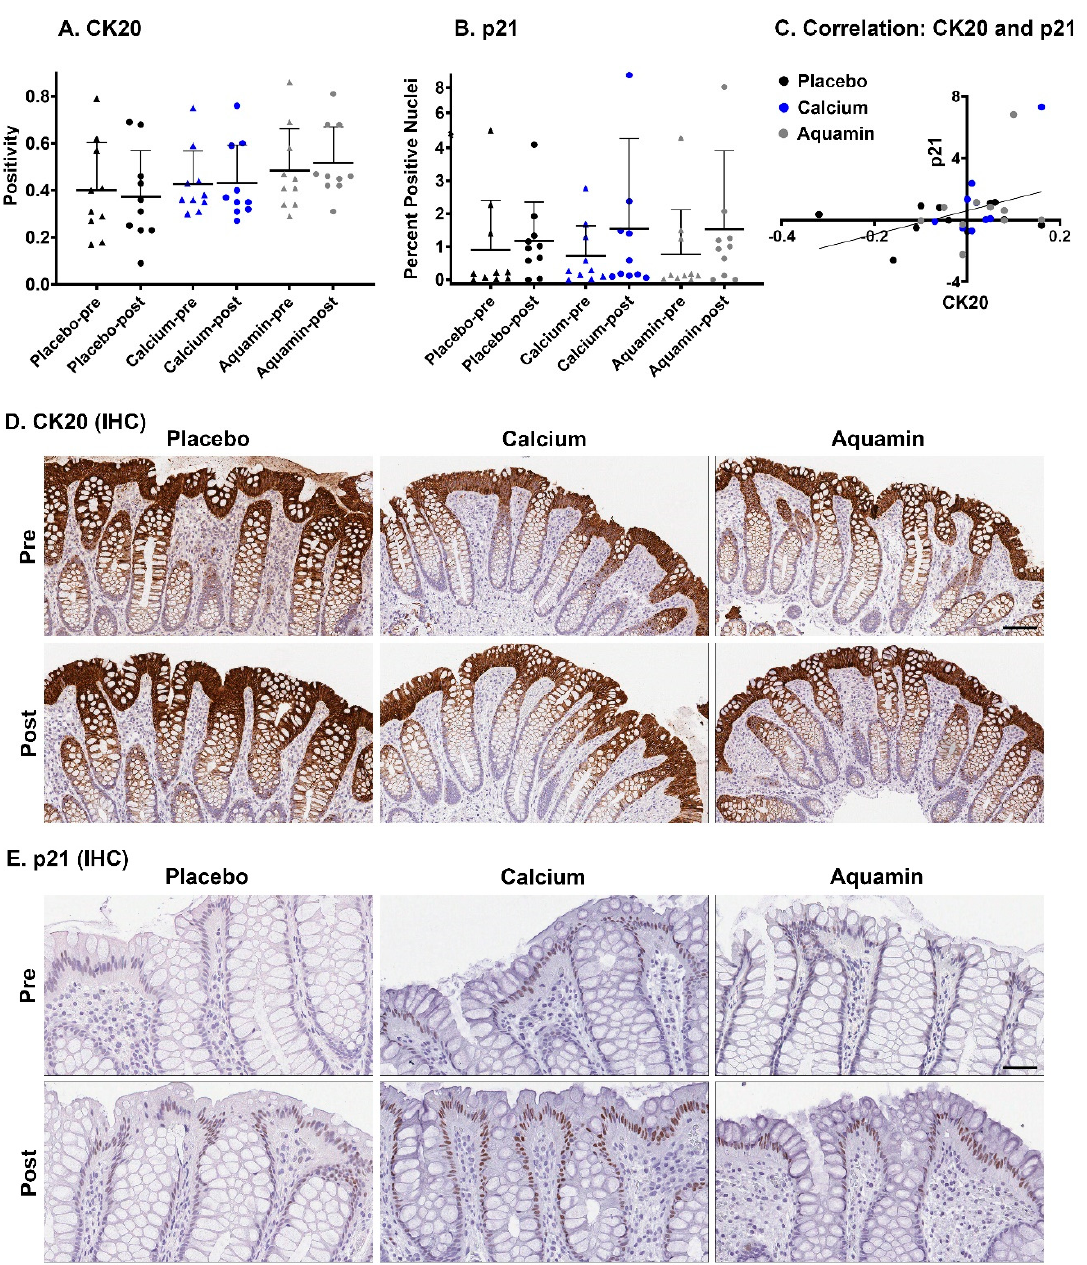
Figure 2. Differentiation panel expression. ( A ): CK20 expression quantitation. CK20 expression is presented by CK20 stain positivity. Values represent means and standard deviations based on evaluation of individual crypts in each colon biopsy (P:106 and 81, CA:63 and 65, AQ:102 and 82–number of pre and post crypts respectively) and luminal surface per treatment group (10 subjects per group before and after treatment for 90 days). ( B ): p21 expression quantitation. Percentage of strong positive (2+ and 3+) nuclei is used to present p21 expression. Values represent means and standard deviations based on evaluation of individual crypts in each colon biopsy (P:106 and 78, CA:59 and 63, AQ:103 and 65–number of pre and post crypts respectively) and luminal epithelial cells per treatment group (10 subjects per group before and after treatment for 90 days). ( C ): Correlation of CK20 and p21 expressions in all 30 subjects. r = 0.3819; p (two-tailed) = 0.0373. Each dot represents an individual subject (A–C). ( D ): CK20-stained histological images of colonic mucosa from a representative subject of each treatment group before and after the 90-day intervention. Scale bar = 100 μ m. ( E ): p21-stained histological images of colonic mucosa from a representative subject of each treatment group before and after the 90-day intervention. Scale bar = 50 μ m.